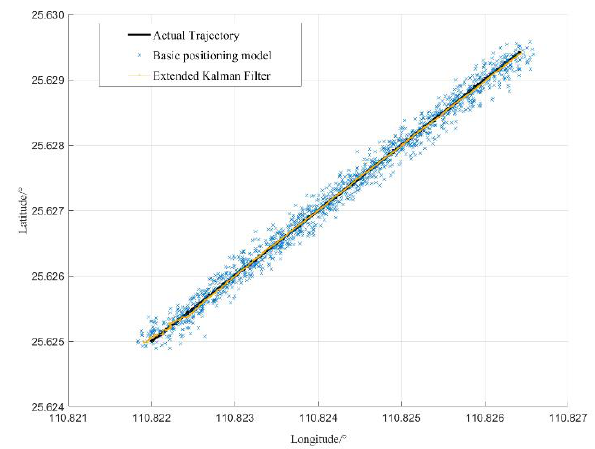
Figure 17. Schematic diagram of moving target positioning result.